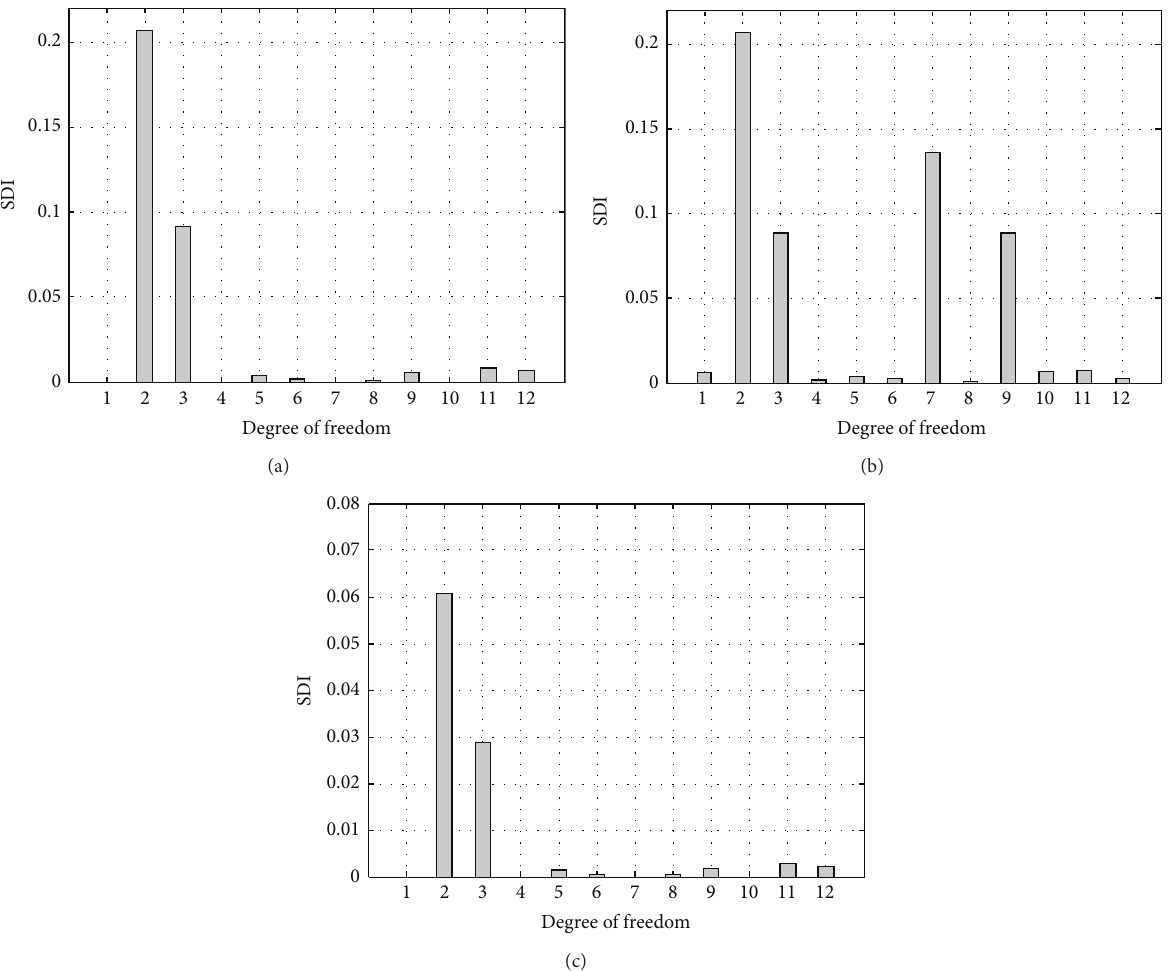
Figure 19: (a) value of SDI in the benchmark structure considering 5 modes for scenario 1, (b) value of SDI in the benchmark structure considering 5 modes for scenario 2, and (c) value of SDI in the benchmark structure considering 5 modes for scenario 3.